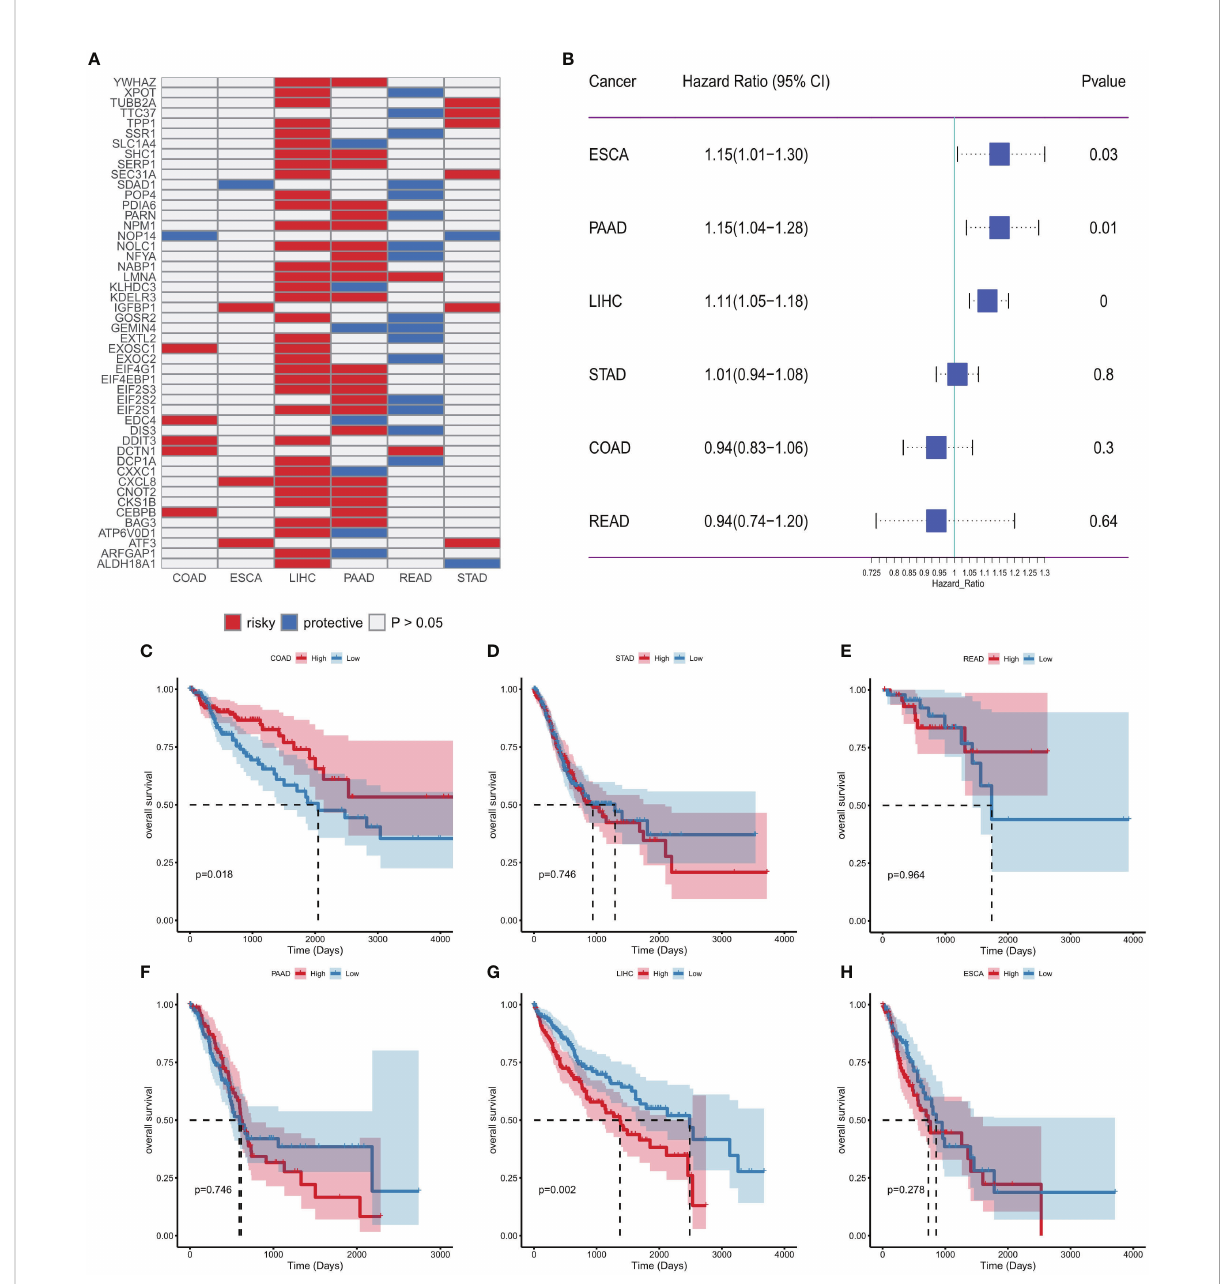
FIGURE 6 Effect of endoplasmic reticulum stress factors on prognosis. (A) Endoplasmic reticulum stress factors associated with overall survival in at least two cancers; (B) Results of univariate Cox analysis of CXCL8; (C – H) KM curves of CXCL8 in different tumors (median